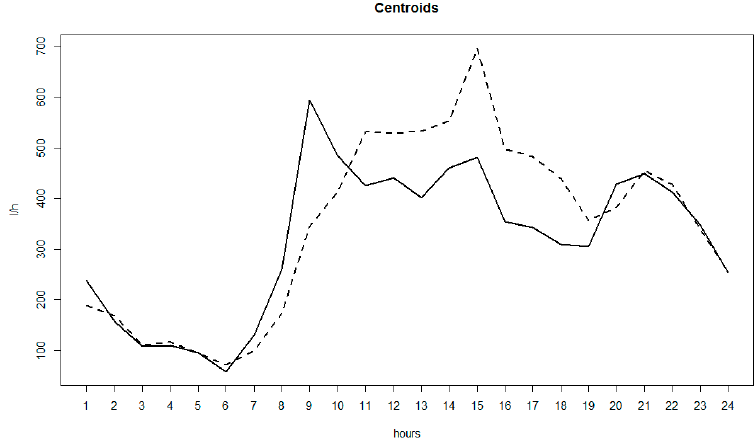
Figure 8. Case 2—a non-residential customer: results from clustering (dotted line is the pattern associated with Sunday, Monday, and holidays).